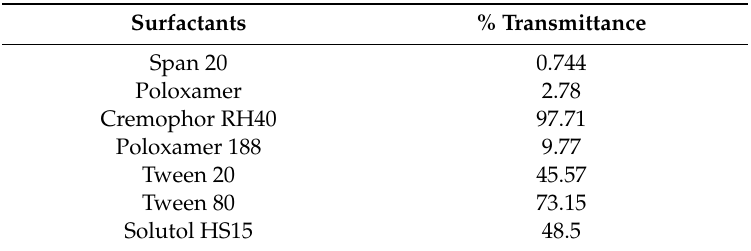
Table 3. % Transmittance of surfactants.